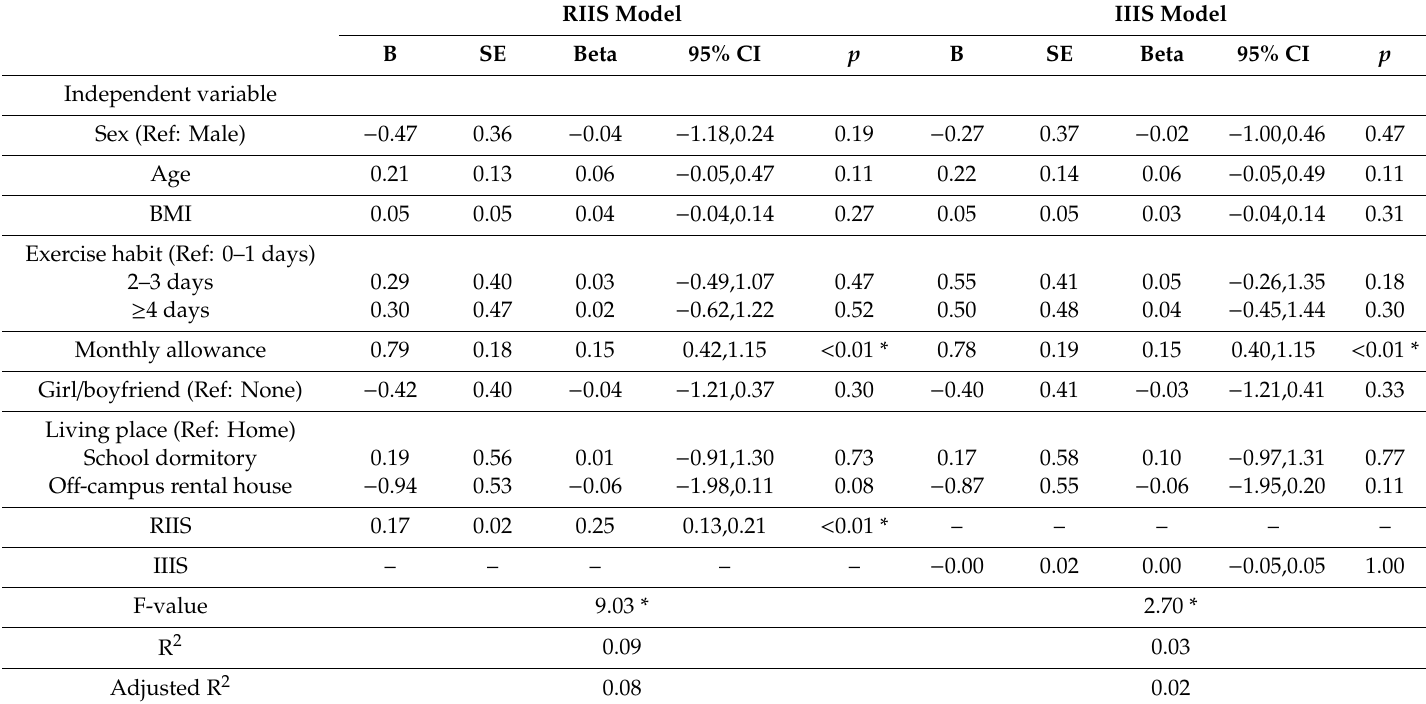
Table 4. Multiple regression analysis on factors a ff ecting self-e ffi cacy (i.e., General Self-E ffi cacy Scale; GSE) by interpersonal interaction (real and